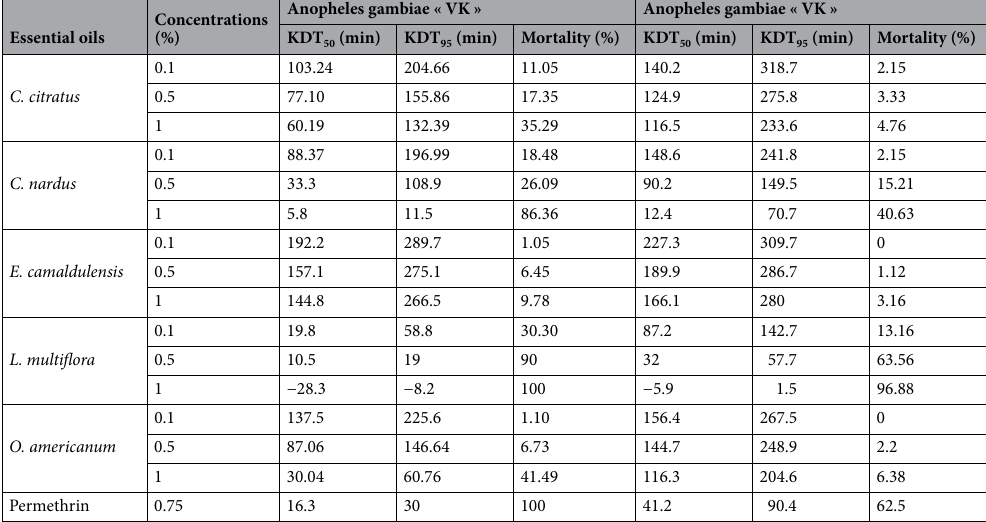
Table 4. KDT 50 , KDT 95 and rates of mortality of essential oils tested on the susceptibility (Kisumu) and field (VK) strains of Anopheles gambiae. KDT 50 : 50% of mosquitoes knock down time; KDT 95 : 95% of mosquitoes knock down time; VK : Vallée du Kou; %: percentage; min :